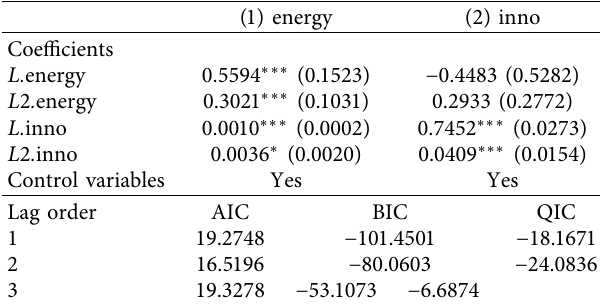
Table 3: Estimated results of the PVAR system.